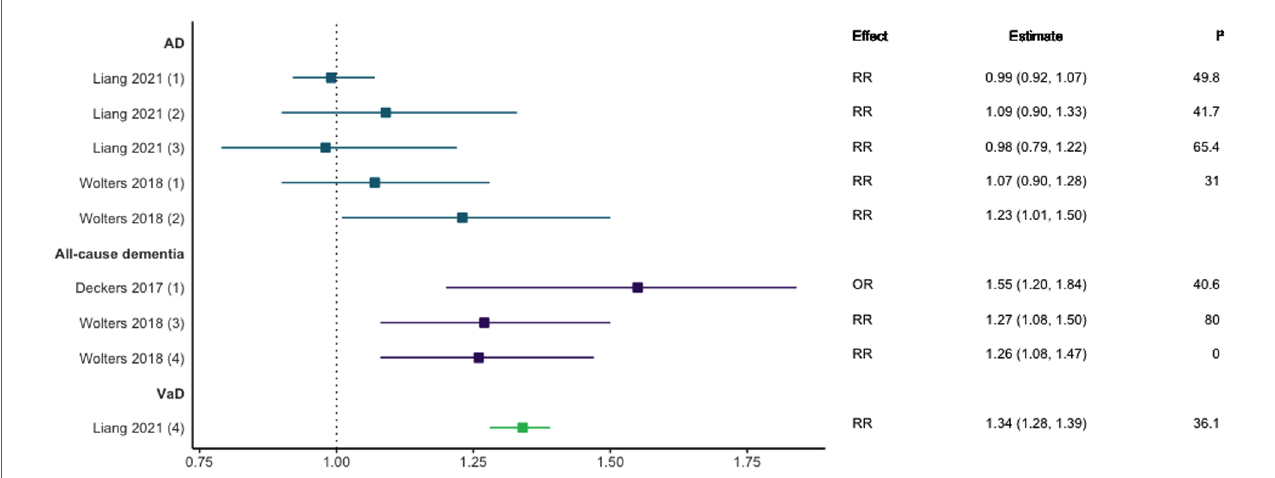
FIGURE 2 Effect estimates and 95% con fi dence intervals of meta-analyses reporting an association between CHD and dementia, with the vertical line representing no effect. AD, Alzheimer ’ s disease; CHD, coronary heart disease; OR, odds ratio; RR, risk ratio; VaD, vascular